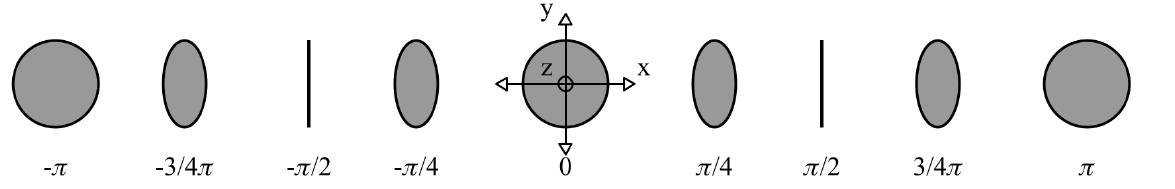
its projected shape will go from a disc to a line. The 2D projected aspect ratio of the thin disc at any angle θ will be